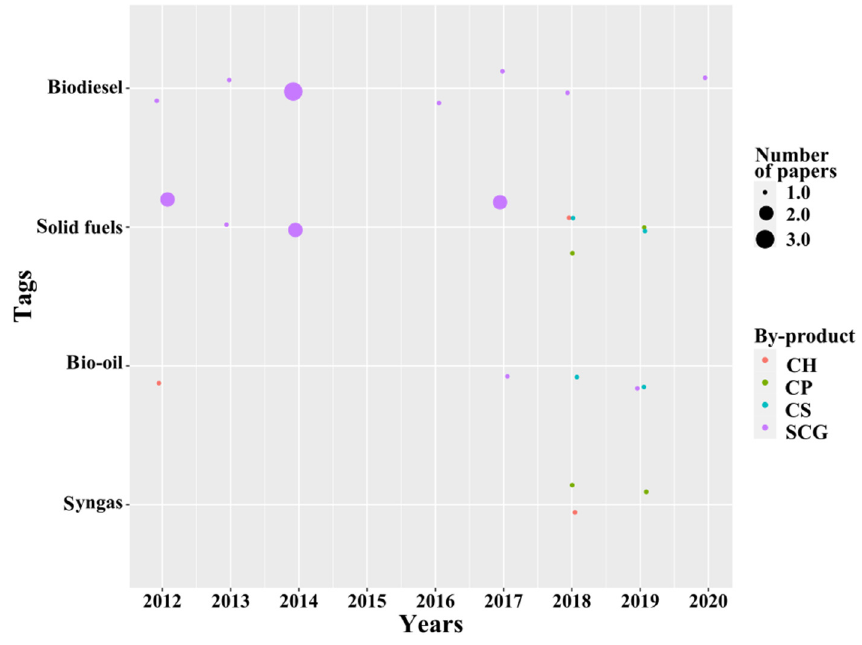
Figure 10. Temporal analysis of biofuels from thermochemical processes.